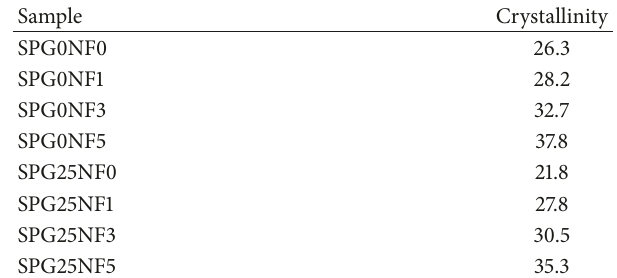
Figure 1: SEM image of cellulose nanofibers from OPEFBs isolated by mechanical treatment.